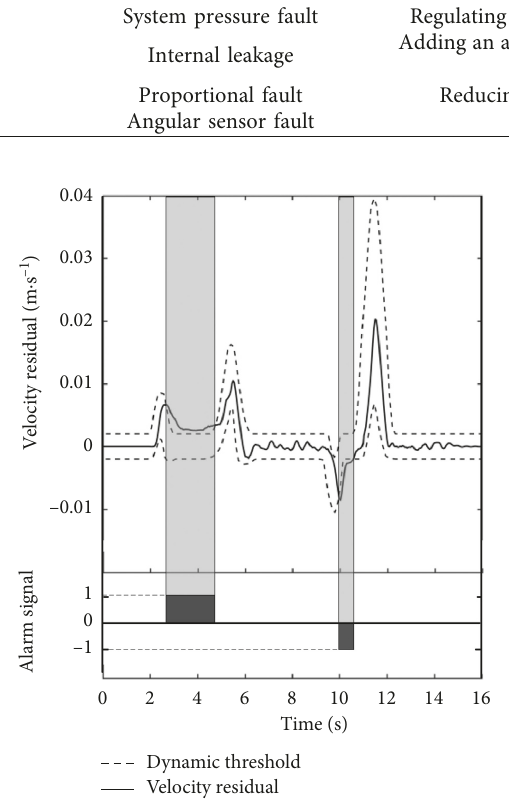
Figure 5: Residuals of system pressure fault and alarm signal.